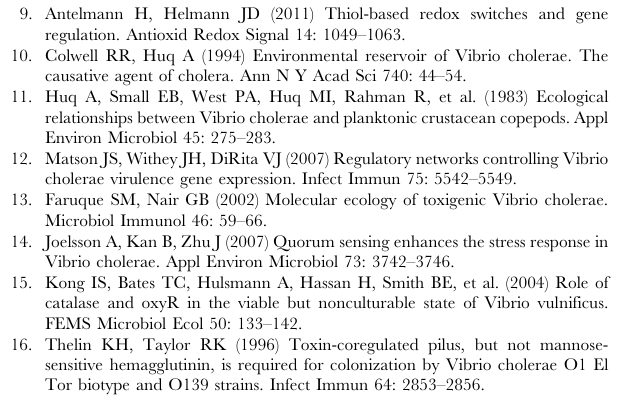
Table S1 Primers used in this study.